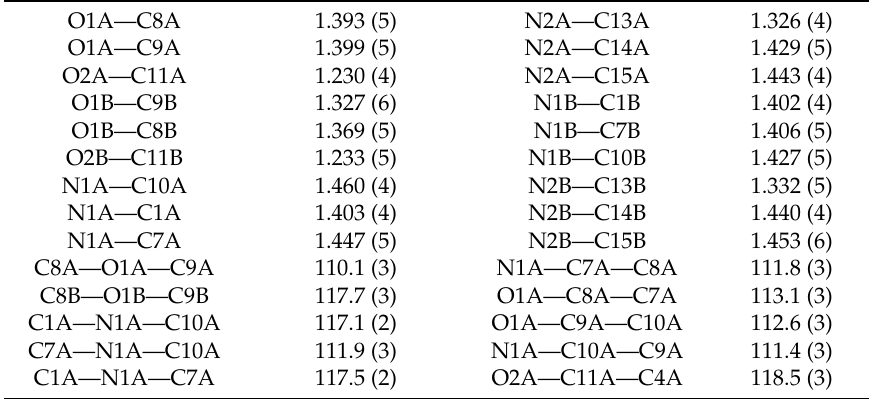
Table 2. Selected geometric parameters